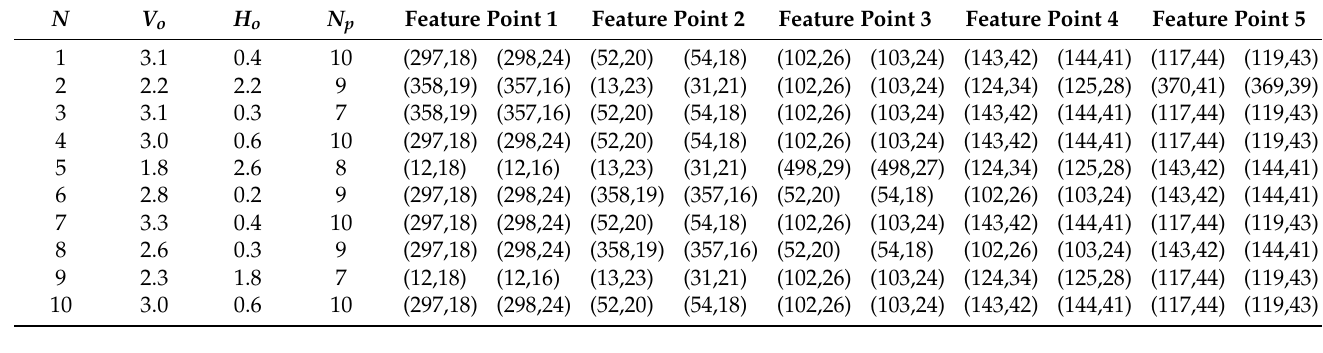
Table 2. Statistical results of match test.